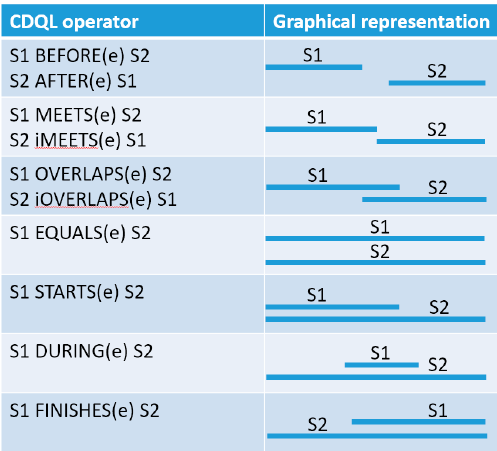
Figure 22. Allen’s algebra graphical representation (i stands for inverse).